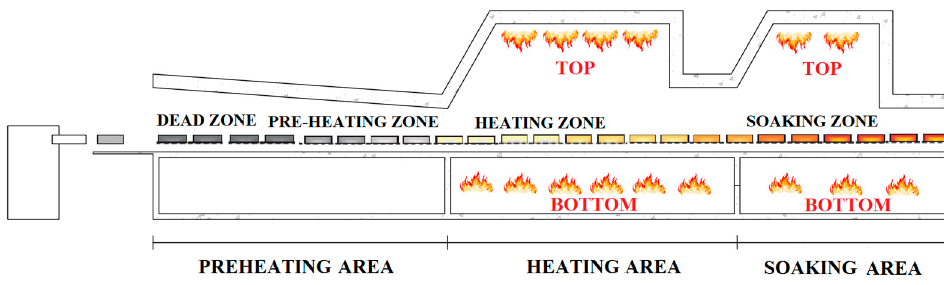
Figure 2. Schematic representation of the reheating furnace.